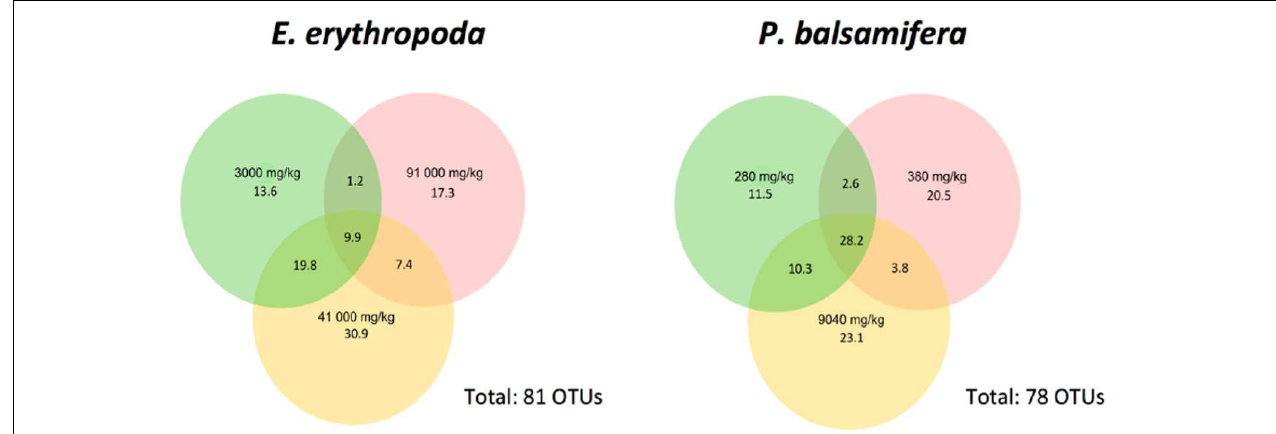
FIGURE 4 | Venn diagram showing the distribution of fungal OTUs among different concentrations of total petroleum hydrocarbon of E. erythropoda and P. balsamifera . Total petroleum hydrocarbons (TPH) concentration is given in mg/Kg.